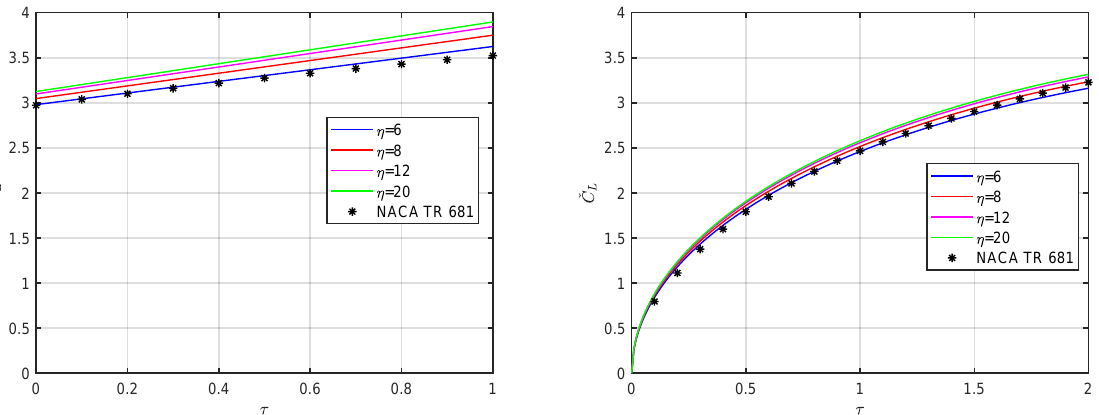
Figure 4. The incipient indicial lift for elliptical thin wings in incompressible flow: AOA ( left ) and SEG ( right ).